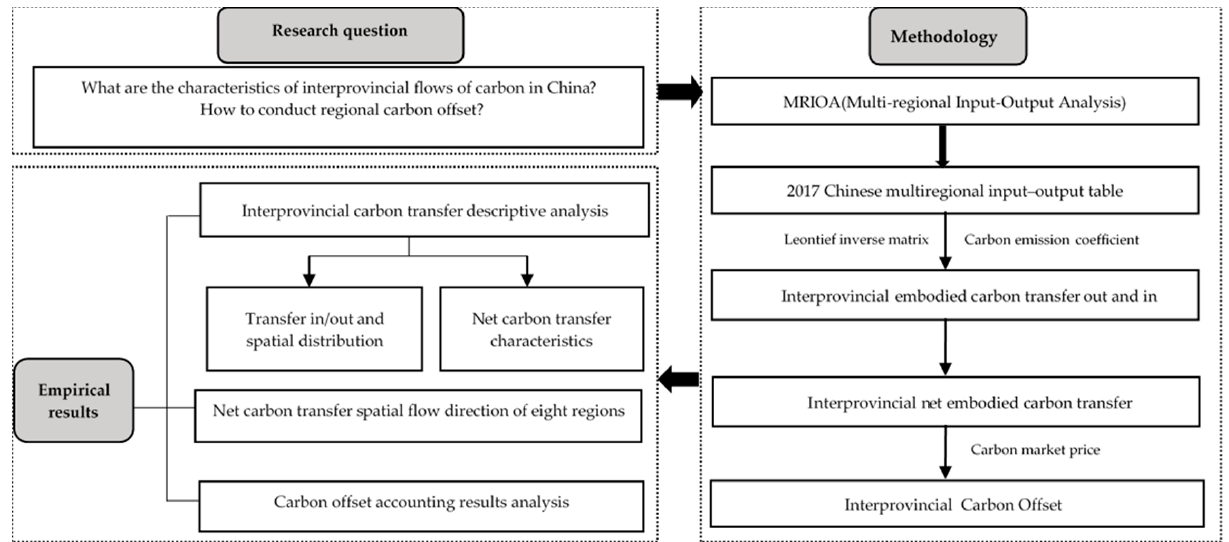
Figure 1. Research flowchart of this study. Source: the authors.